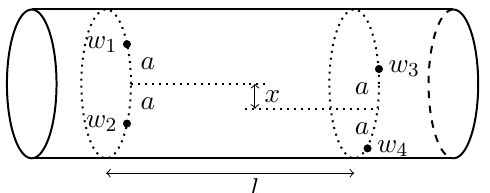
Figure 1 . Four-point functions in the cylinder